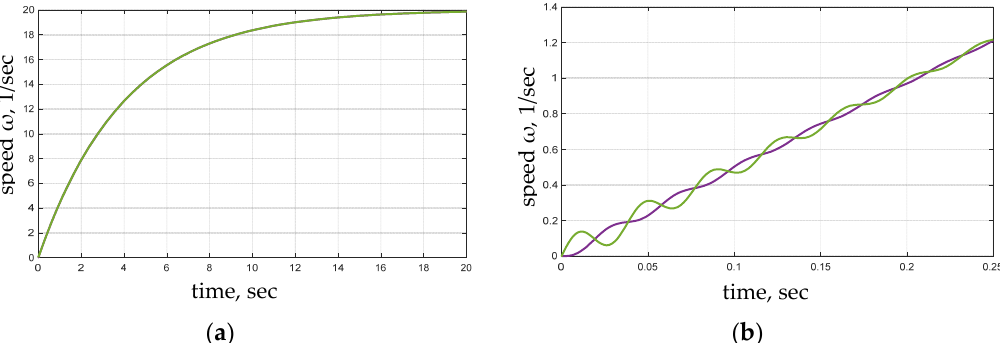
Figure 4. Dependence of the twist angle change Δϕ during acceleration for γ = 0.5.